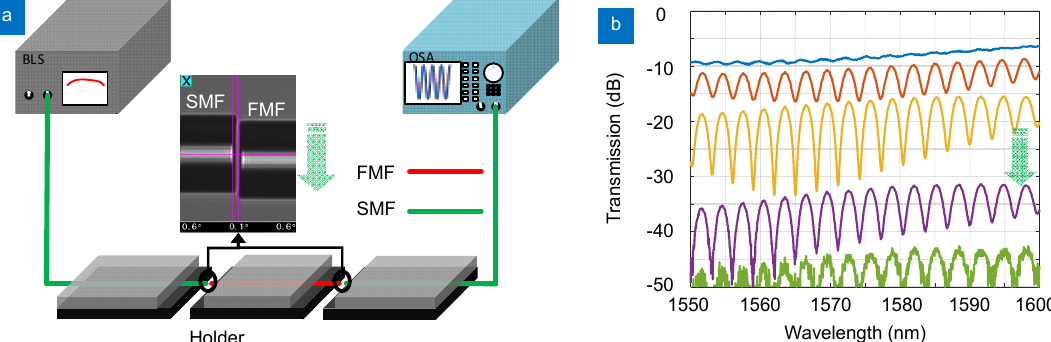
Fig. 3 | The experiment on ER versus offset distance between SMF and FMF to obtain a desired spectrum for sensing (a) and the results regarding TMF: collected spectra with the SMF shifts away from the TMF in transverse direction